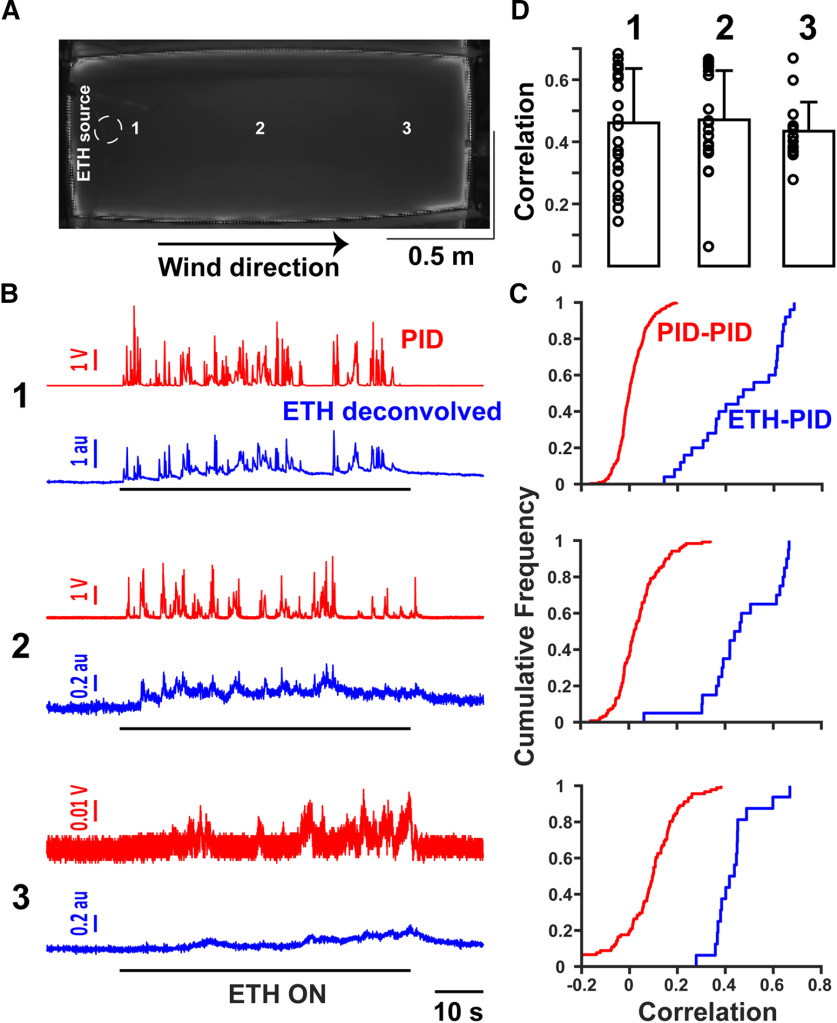
Deconvolved ethanol signals are correlated with the PID responses in turbulent airflow. A, Overhead image of a custom-designed arena [2 m (l), 0.9 m (w), 0.9 m (h)] to create dynamic odor plumes. The dashed circle represents the location of the source of ethanol port while the arrow points out the wind direction. Also indicated are the approximate locations near the port (1), near the middle of the arena (2), and farthest downwind (3) where paired PID and ethanol-sensor recordings were conducted. B, Representative traces of the PID (red) and deconvolved ethanol (blue) signals at the locations indicated in A. The black bars represent the ethanol stimuli. Notice the changing scales for the amplitude at farther distances from the ethanol port. C, Cumulative distributions of PID correlations across pair-wise combinations of different trials (red) versus correlations between the PID and the ethanol signals within a trial (blue) for the different locations. D, Mean ± standard deviation (SD) correlations (bars) at locations near port (1), near the middle of the arena (2), and farthest downwind (3) from the ethanol port. Circles are the correlations of individual trials.